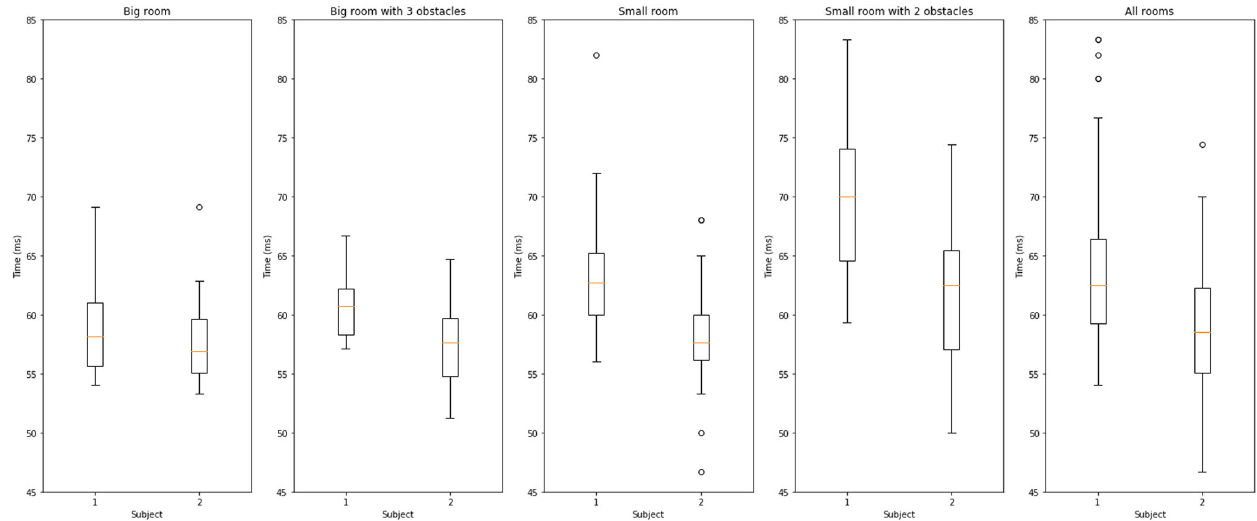
Fig. 7 Stride Time Variability. Stride time variability arising from the home environment. The panels from left to right show box plots of passively recorded stride time for two subjects in four different settings and in aggregate. The error bars of boxplot are generated by matplotlib using the matplotlib.pyplot.boxplot function with default parameters. The boxplot extends from the fi rst to the third quartile of the data with a line at the median. The whiskers extend from the box by 1.5 times the inter-quartile